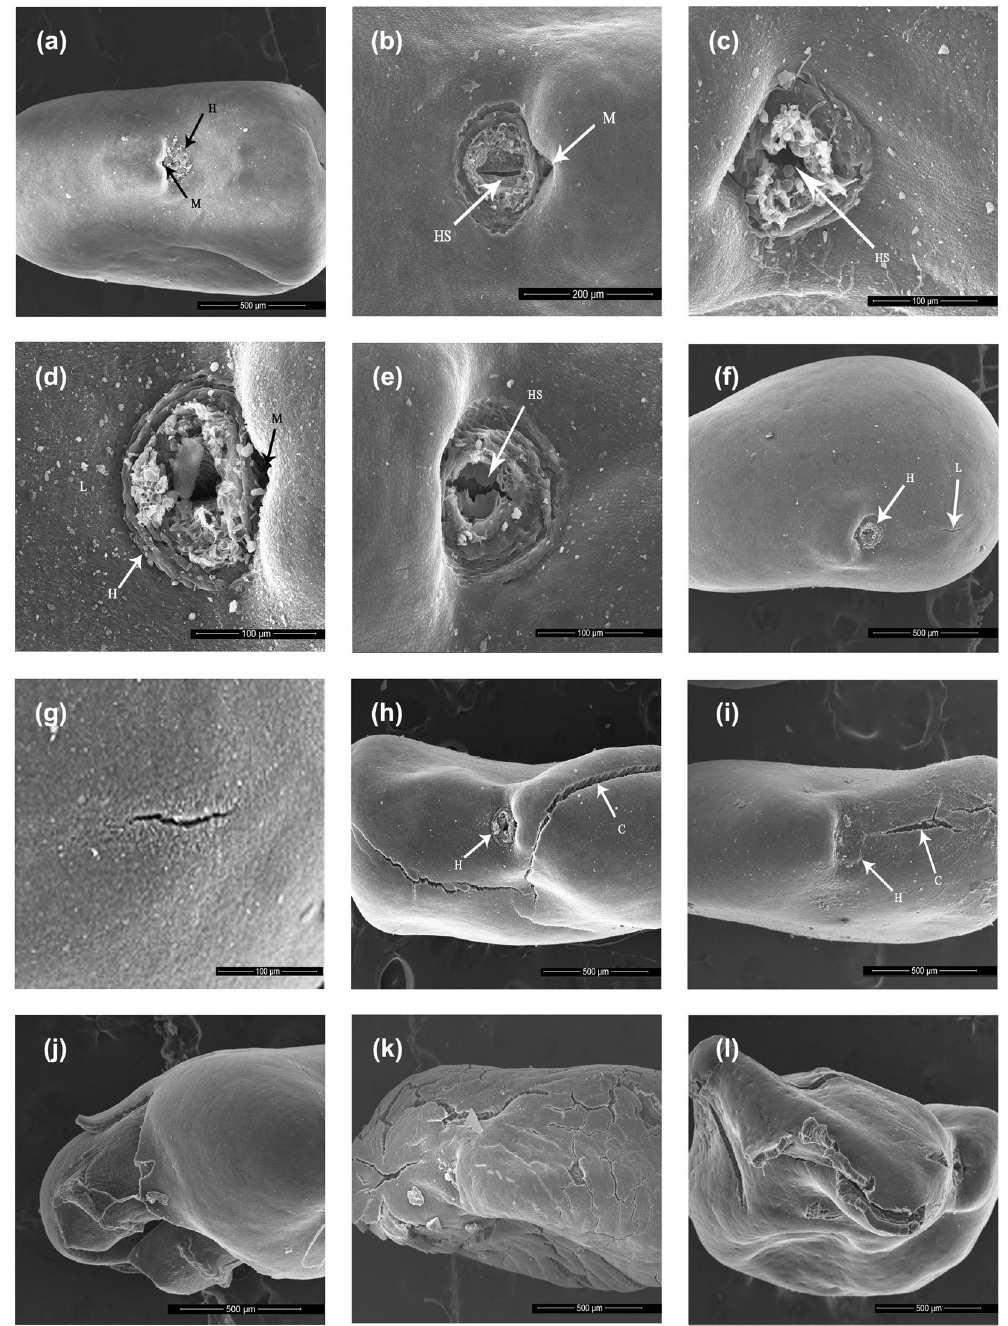
Figure 7. Effect of gut passage on permeable and impermeable seed germination. Seeds recovered were grouped based on time. Different lower-case letters indicate significant differences within group at different time. Different upper-case letters indicate significant differences between permeable and impermeable